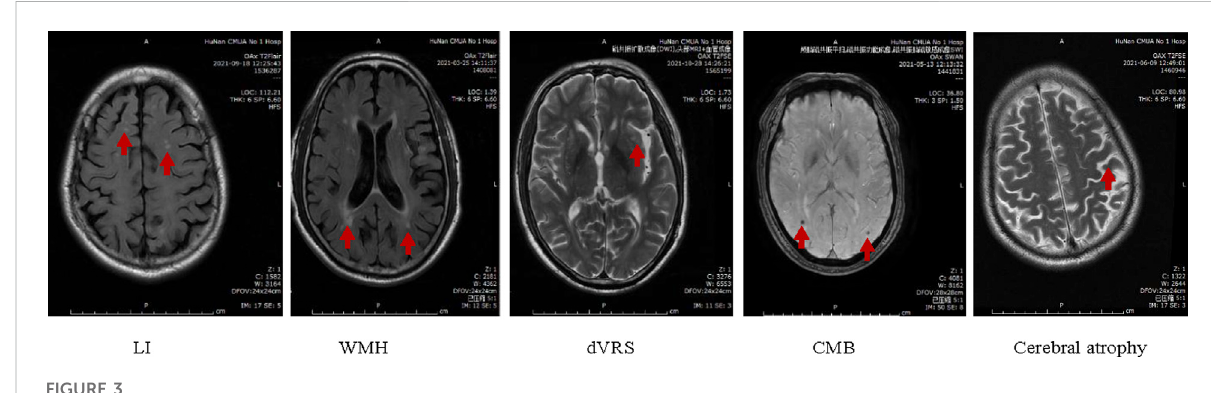
FIGURE 3 Imaging features of